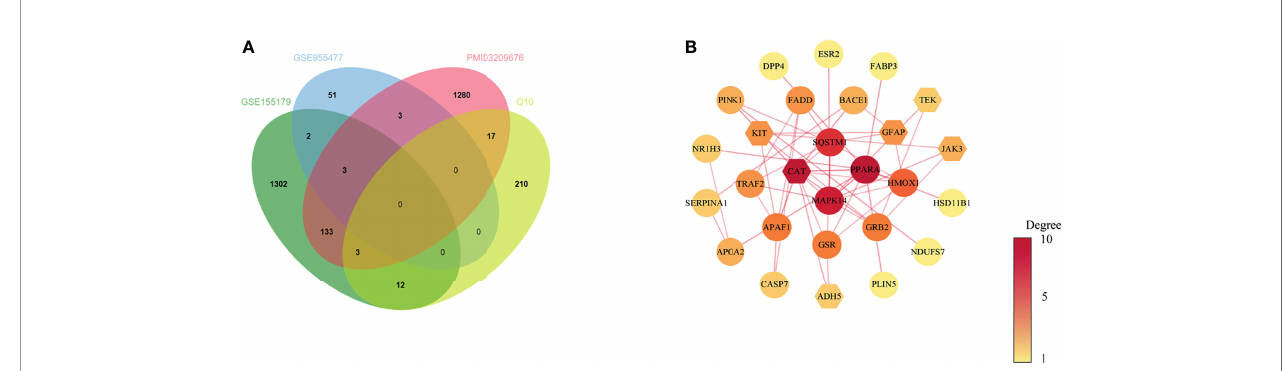
FIGURE 2 | Venn diagram and PPI network of potential therapeutic targets. (A) Venn diagram of intersected targets of oocyte aging and CoQ10. (B) PPI network of potential therapeutic targets. The nodes ’ colors are illustrated from yellow to red in descending order of degree